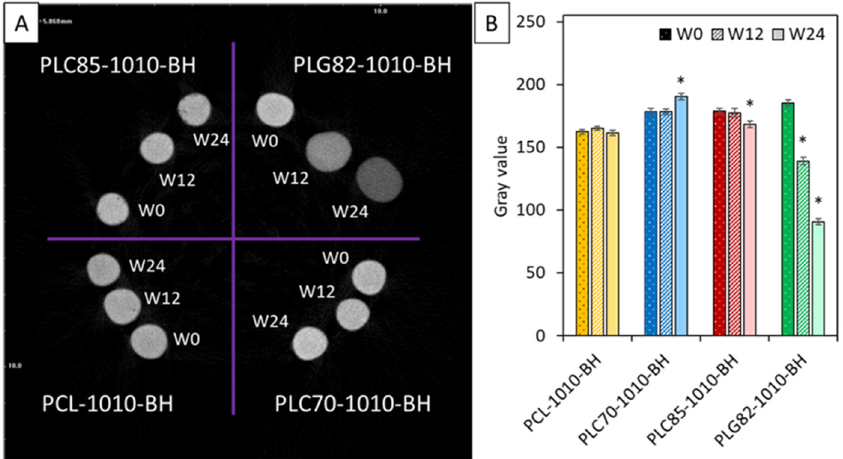
Figure 4. MicroCT results: ( A ) reconstructed cross-section image of tested samples, ( B ) average values of signal intensity in greyscale versus types of materials during degradation. *—when p < 0.05 compared to the initial state (W0).